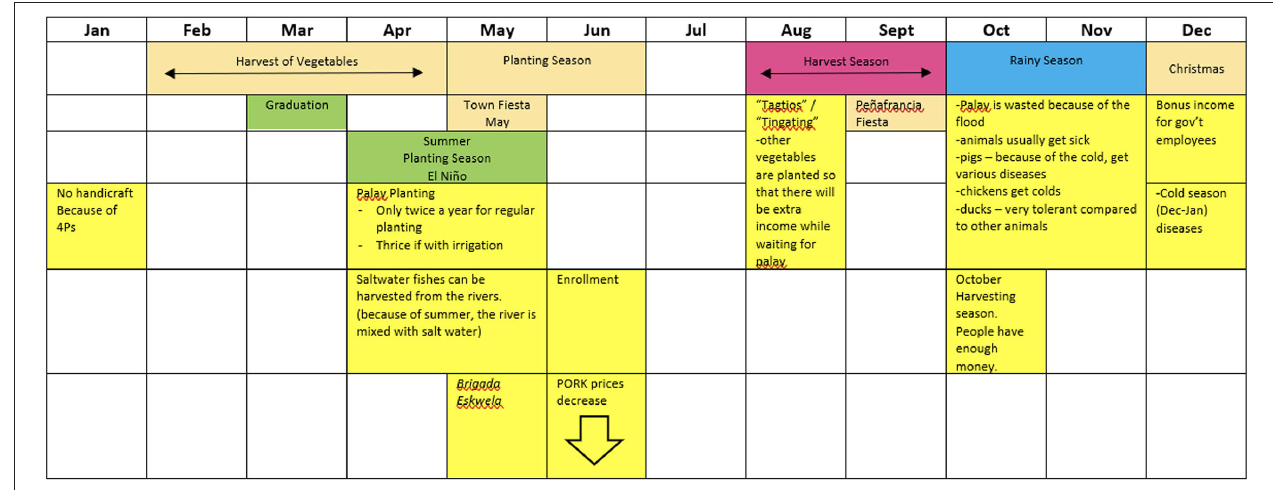
FIGURE 5 | Seasonal calendar constructed by male participants during a focus group discussion in Camarines Sur—Male farmers of 10 pigs or fewer CSFGD2.